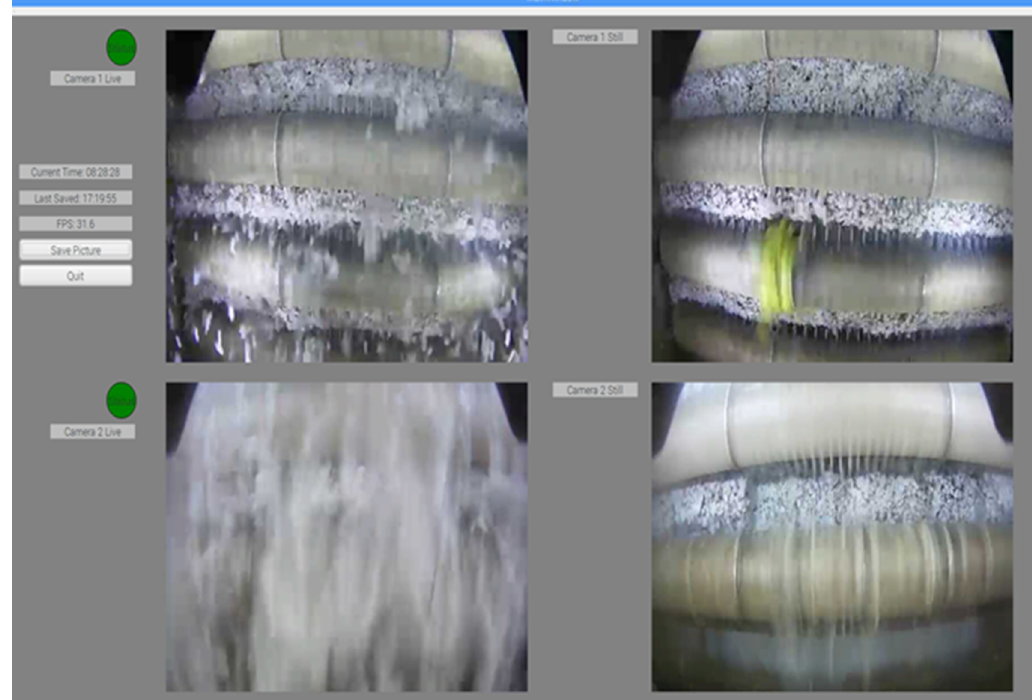
Figure 7. Module feeder custom software (option 2: Schedule Release Q3 2020) where installation utilized two cameras (one top, one bottom). The left-side of display shows images that are of the live feed from the cameras. The right-side images are the captured images that were taken after the software paused the module feed, thereby allowing cotton to settle out of the air, providing a clear camera shot of the